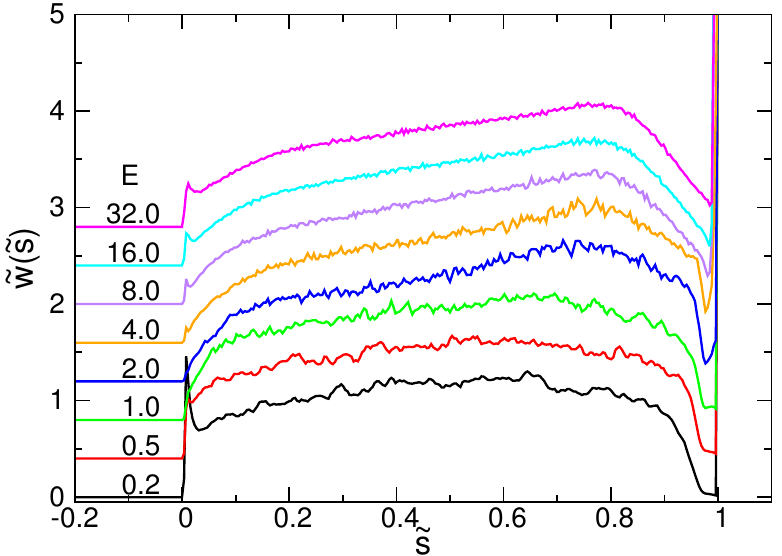
Figure 7. Normalized waiting time function ˜ w ( ˜ s ) for N = 256 at different field strengths E indicated at the left of the curves. ˜ s is defined as s / N . The curves have been shifted upward with a fixed value, one after the